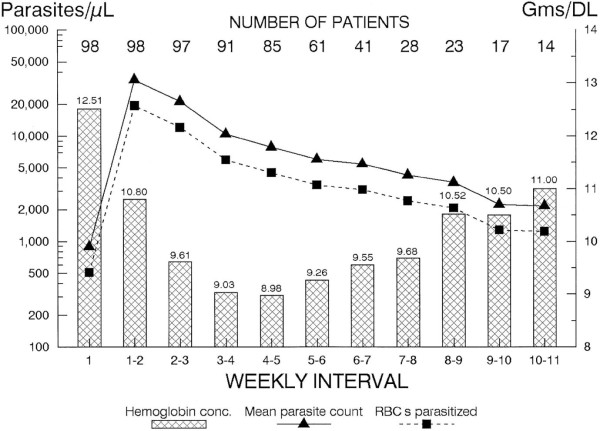
Mean haemoglobin concentration in relation to parasitaemia in patients with syphilis treated with inducedP. vivaxinfections (98 with the St Elizabeth strain, 11 with the Chesson strain and 2 with the Korean strain). Reproduced with permission from Collins WE, et al. [73].